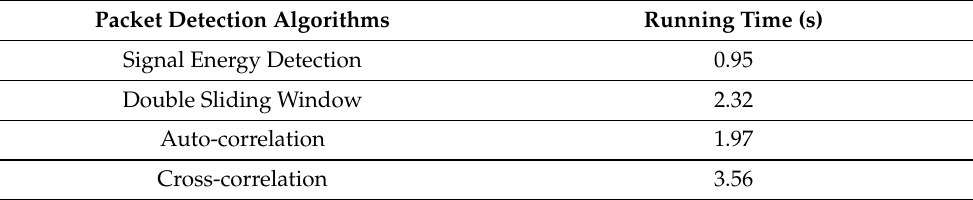
Table 2. Running time for four algorithms.